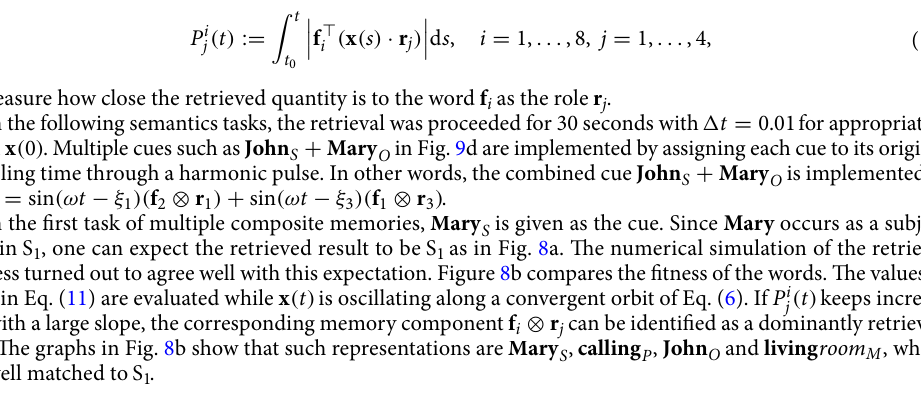
j ( t ) are colored red, which turned out to correspond to S 1 i